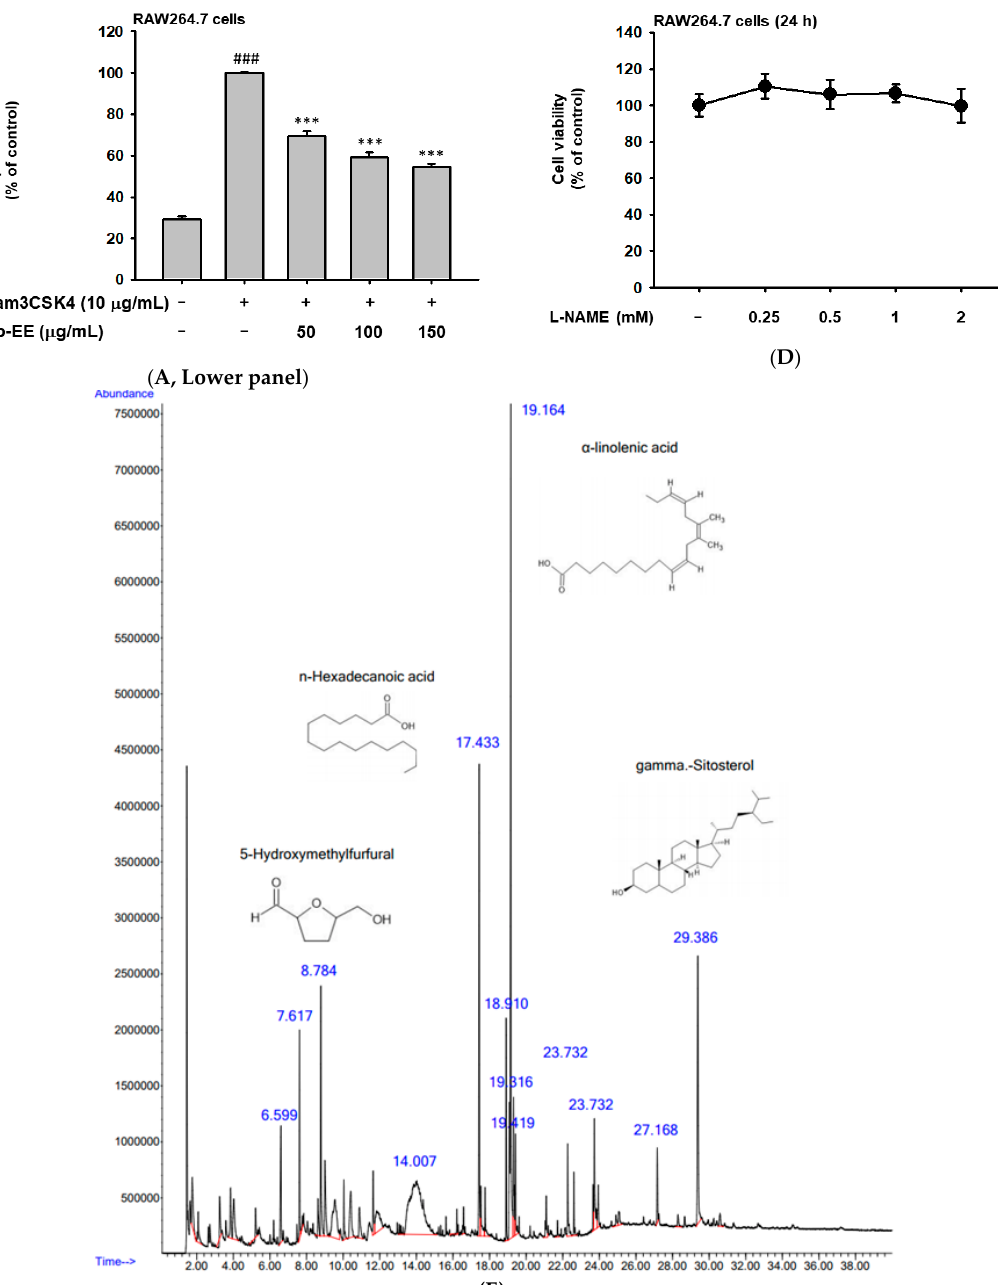
Figure 1. Effect of Potentilla paradoxa Nutt. ethanol extract (Pp-EE) on NO production and cell viability. ( A ) NO production from the supernatants of RAW264.7 cells pretreated with various concentrations of Pp-EE (50–150 µ g/mL) for 30 min and treated with respective inflammatory substances (lipopolysaccharide (LPS) (1 µ g/mL) (upper panel), polyinosinic:polycytidylic acid (Poly (I:C)) (200 µ g/mL) (middle panel), or Pam3CysSerLys4 (Pam3CSK4) (10 µ g/mL) (lower panel)) for 24 h. The NO production level was measured through a Griess assay. ( B ) Cytotoxicity of Pp-EE in RAW264.7 cells treated for 12 h and 24 h. The cell survival rate was measured with an MTT assay. ( C , D ) Treatment of N(G)-nitro-L-arginine methyl ester (L-NAME) (0–2 mM) in RAW264.7 cells for 24 h for efficacy comparison. Changes in NO production and effects on cell visibility were measured. ( E ) The analysis of phytochemicals in Pp-EE by GC–MS. The name and molecular structure of high- content phytochemicals are displayed. ###: p < 0.001 and ##: p < 0.01 compared to the normal group, *: p < 0.05, **: p < 0.01, and ***: p < 0.001 compared to the control group. − : no treatment and +: